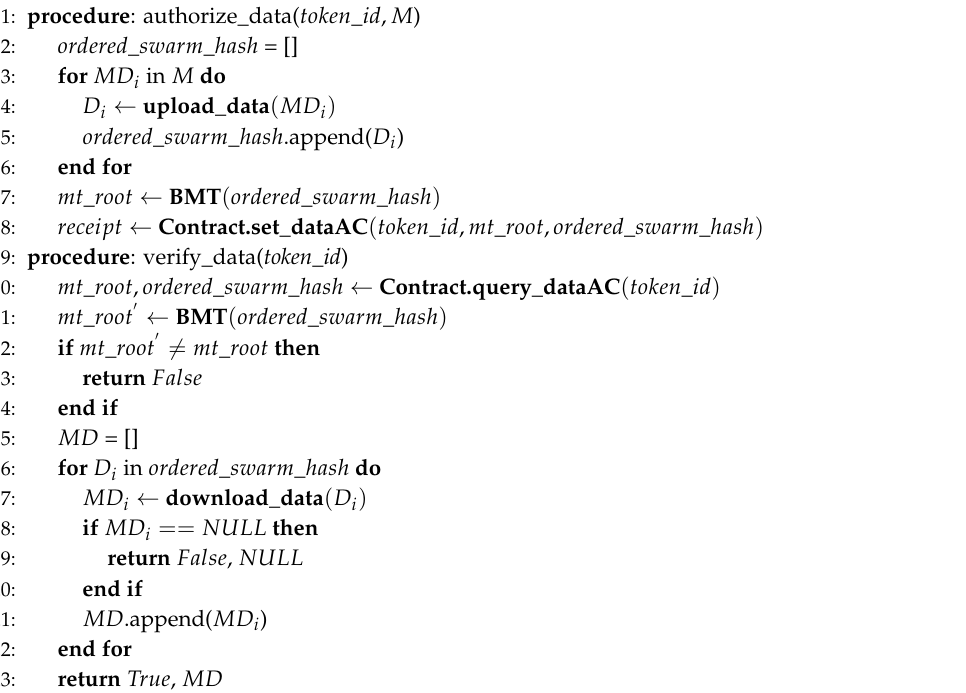
Algorithm 1 The data access authorization and integrity verification